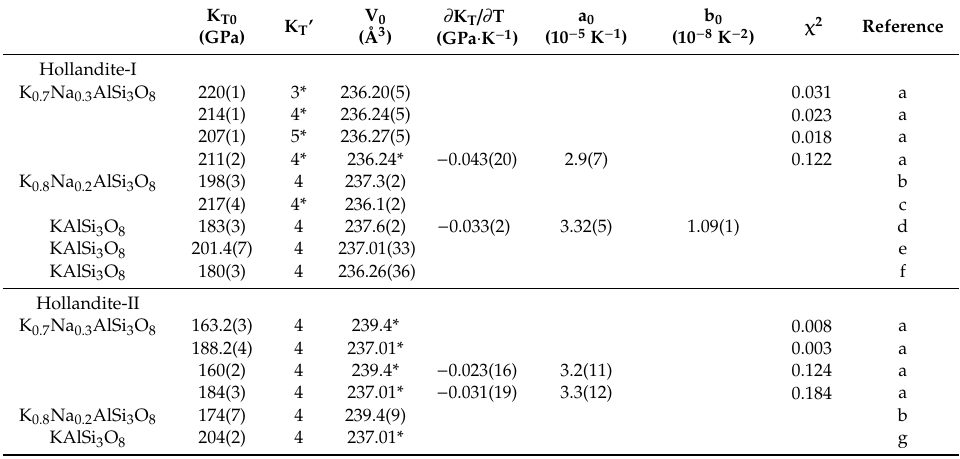
Table 4. Thermoelastic parameters of hollandite-I and hollandite-II phases in the system KAlSi 3 O 8 –NaAlSi 3 O 8 . K T0